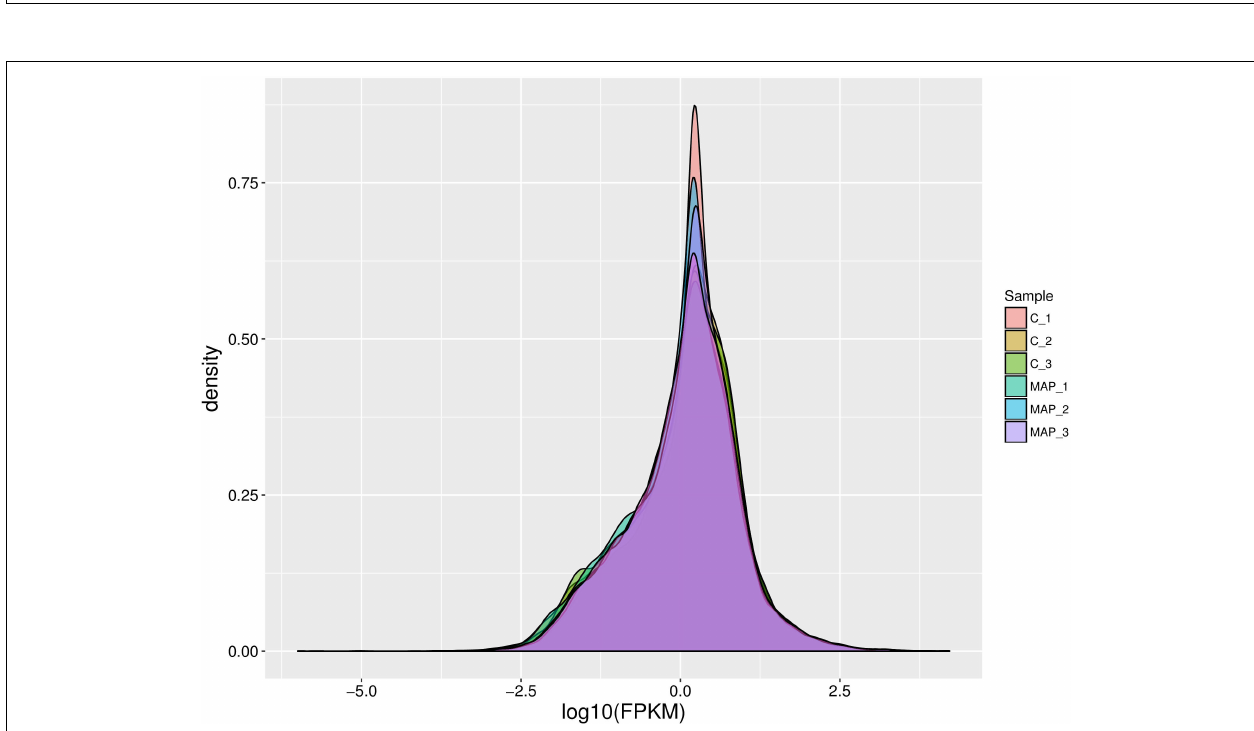
FIGURE 3 | Density map of gene expression values of different samples. The abscissa is log10 (FPKM), and the ordinate is the density of genes.